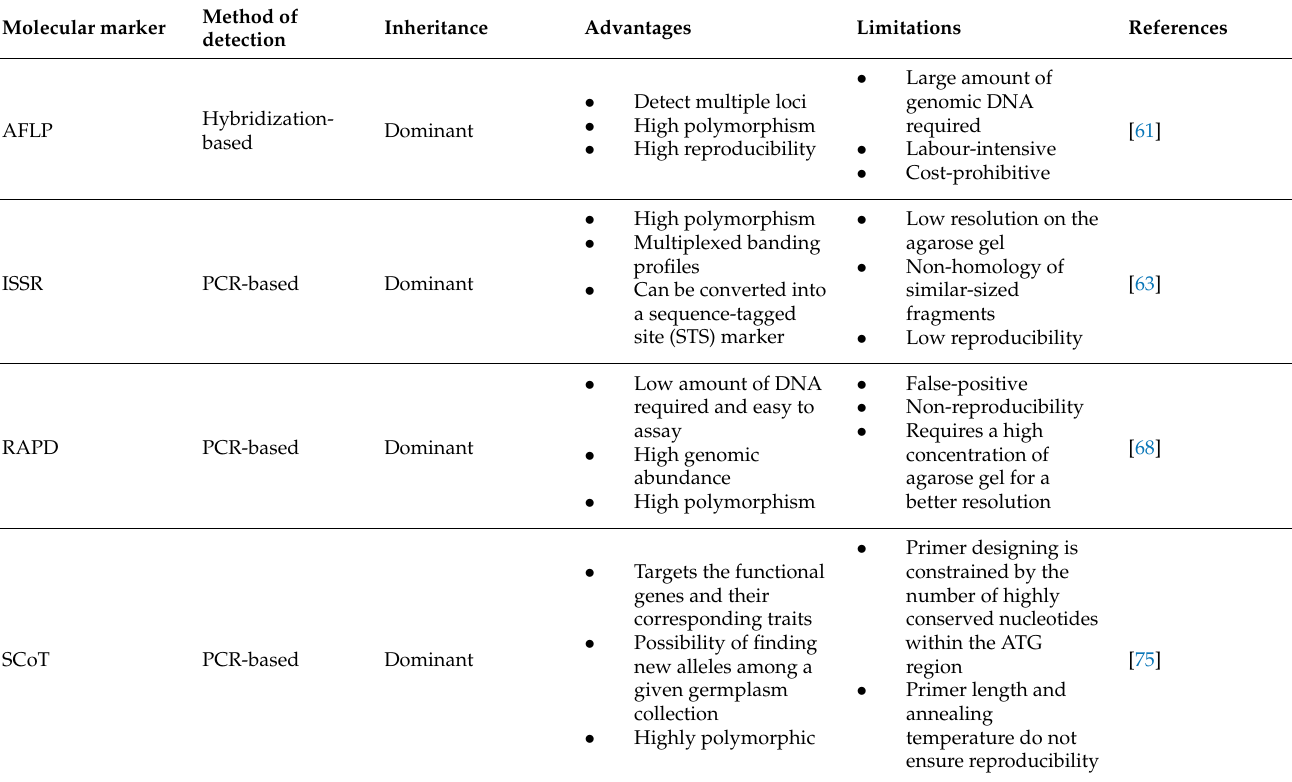
Table 2. Characteristics of the molecular markers used for assaying the genetic diversity in MO